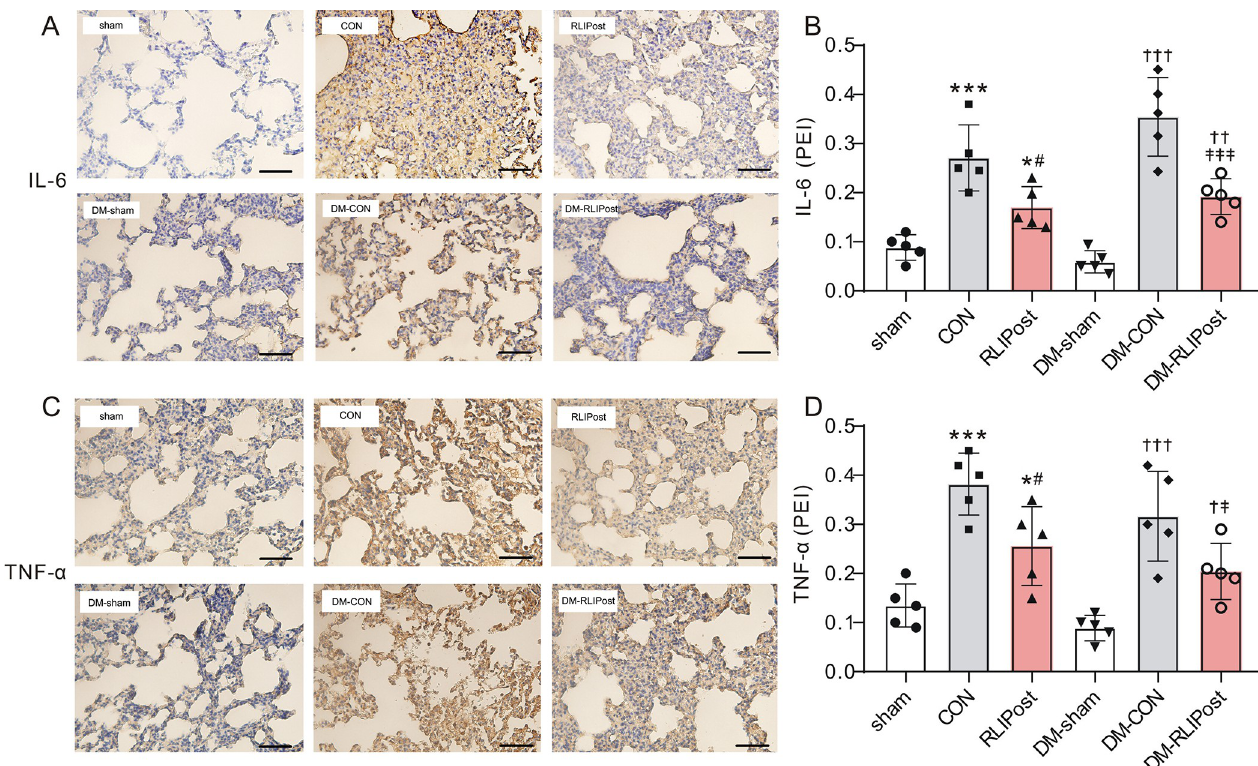
Fig 4. Effects of RLIPost on the expression of inflammatory cytokine. A. Representative immunostainings of IL-6 protein in the lung tissue sections obtained after 2h of reperfusion. sham: sham-operated, CON: control, RLIPost: remote liver ischemia postconditioning, DM: STZ-induced diabetes. scale bars, 50 μ m. B. Densitometric analysis of IL-6 protein expression. n = 5 in each group. Values are mean ± SD. � P < 0.05, ��� P < 0.001, versus the sham group, # P < 0.05, versus the CON group, †† P < 0.01, ††† P < 0.001 versus the DM-sham group, ‡‡‡ : P < 0.001 vs. DM-CON. C. Representative immunostainings of TNF- α protein in the lung tissue sections obtained after 2h of reperfusion. D. Densitometric analysis of TNF- α protein expression. n = 5 in each group. Values are mean ± SD. � P < 0.05, ��� P < 0.001, versus the sham group, # P < 0.05, versus the CON group, † P < 0.05, ††† P < 0.001 versus the DM-sham group, ‡ : P < 0.05 vs.